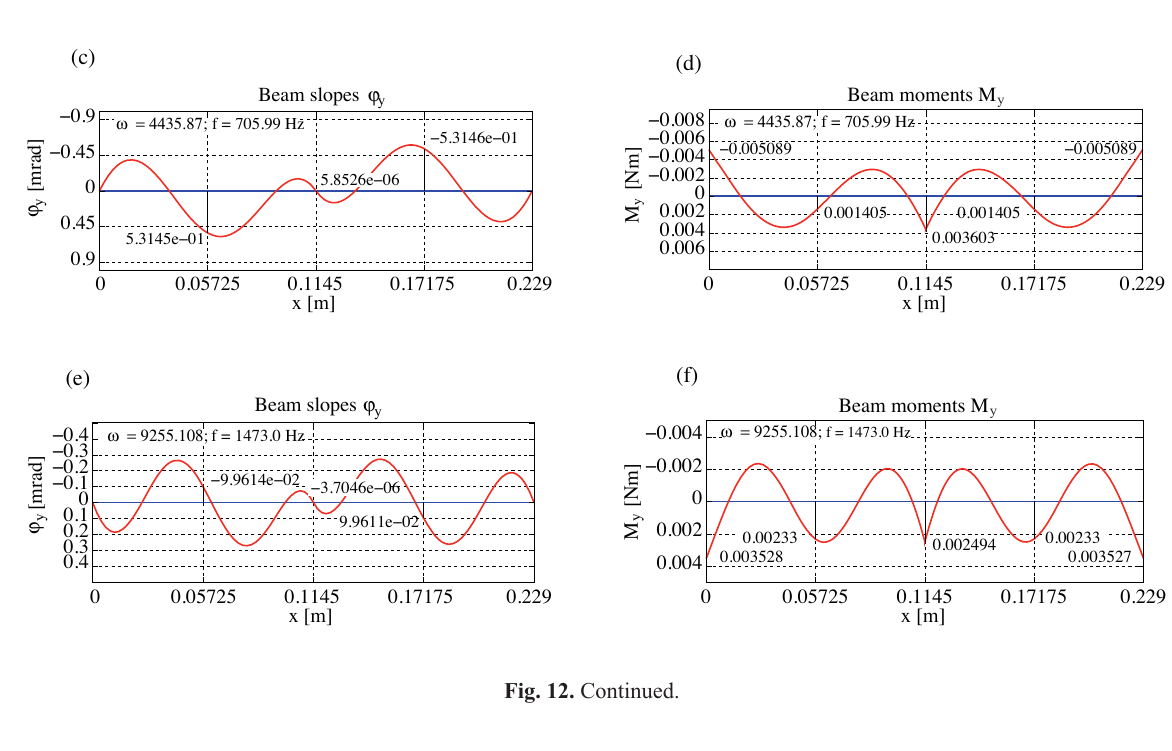
Figure 13 illustrates the amplitudes of displacements and forces of the fixed-fixed beam at 60 Hz frequency.